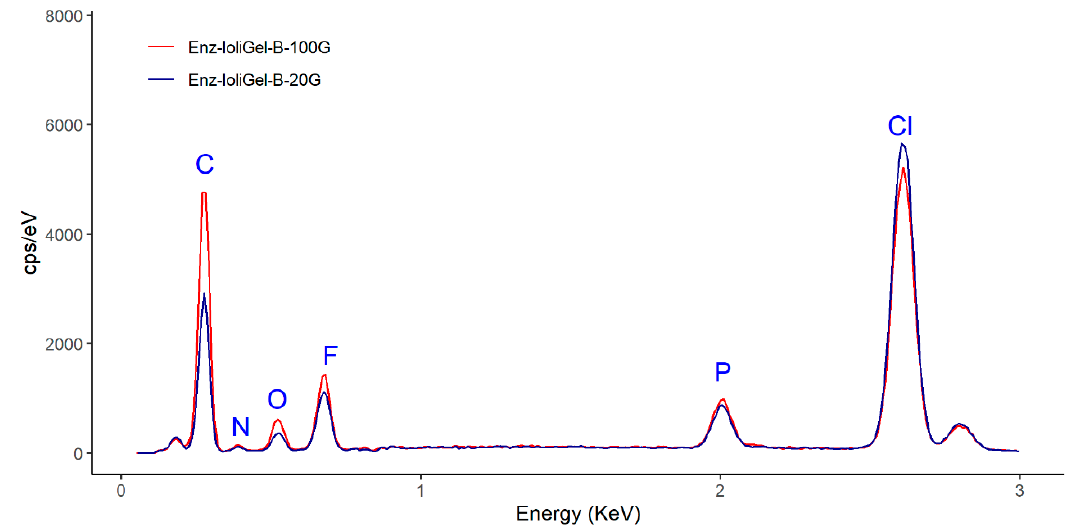
Figure 9. EDX spectra of the ionogel enzymatic derivative (Enz-ionogel-B-20,100G): ( a ) 100 μ L